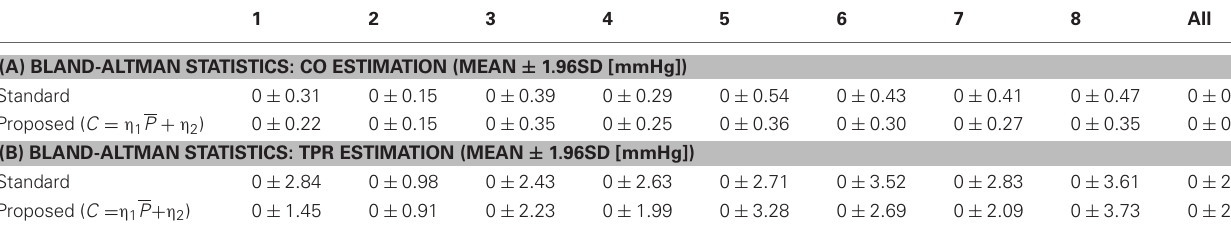
Table 3 | Limits of agreement between measured versus estimated CO and TPR.